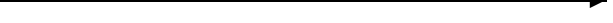
Fig. 1a–c. The dynamic spectrum of the AKR showing upper frequency cuto(cid:128)s, obtained with POLRAD on the 25th of January, 1997. a A quick look 1 h spectrogram received with the antenna X. Upper frequency cuto(cid:128)s (UFCs) are indicated by bars above the spectrogram. Power density estimated from the colour scale should be multiplied by 100 to compensate the 20 dB input attenuation of the receiver. b Zoom of the same spectrogram showing the detailed spectrum of one of the UFCs in time interval from 10.41 to 10.43 UT. c Eight selected frequency profiles for the SFA sweeps indicated by numbers in the middle panel. The profiles are built up from points separated by 4.096 kHz intervals (SFA frequency steps). For comparison the instrumental frequency profile of channel X is